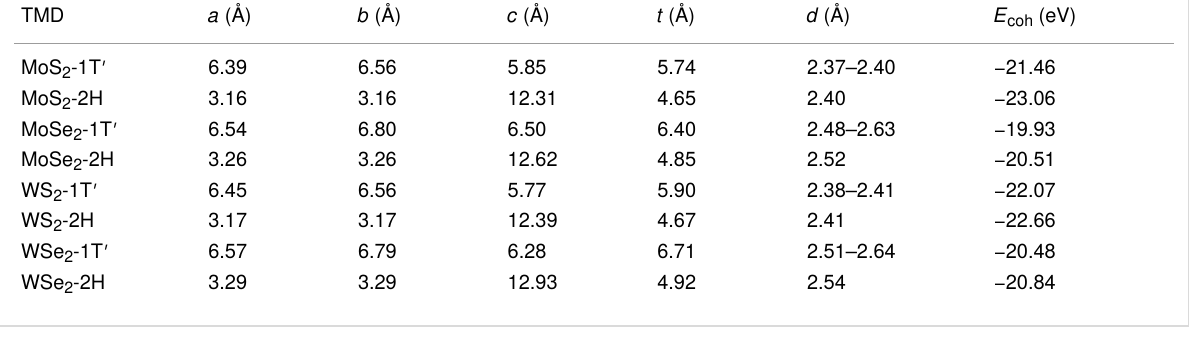
Table 1: Calculated lattice constants a (Å), b (Å), and c (Å), average monolayer thickness t (Å), bond length d (Å) and cohesive energy E coh (eV) of 1T ′ and 2H layered-structured TMDs. TMD